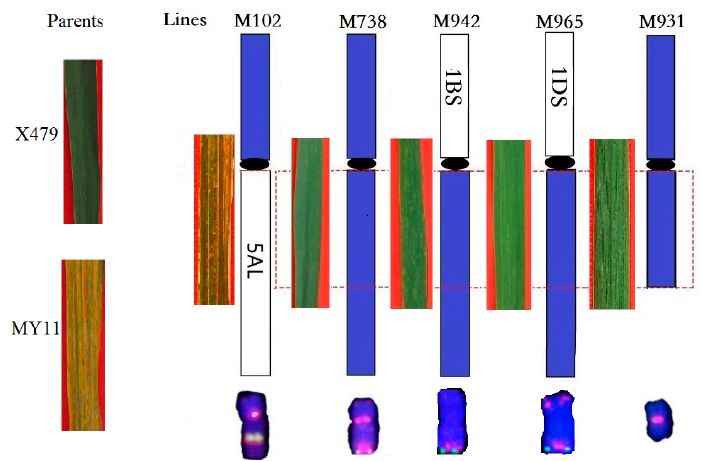
Figure 7. Physical location of wheat- Th. intermedium lines using rust resistance survey and ND-FISH. The left diagrams show the stripe resistance of leaves of parents and derived lines, and the chromosomes variation on the bottom with ND-FISH using probes Oligo-pSc119.2 (green) and Oligo-pTa535 (red).